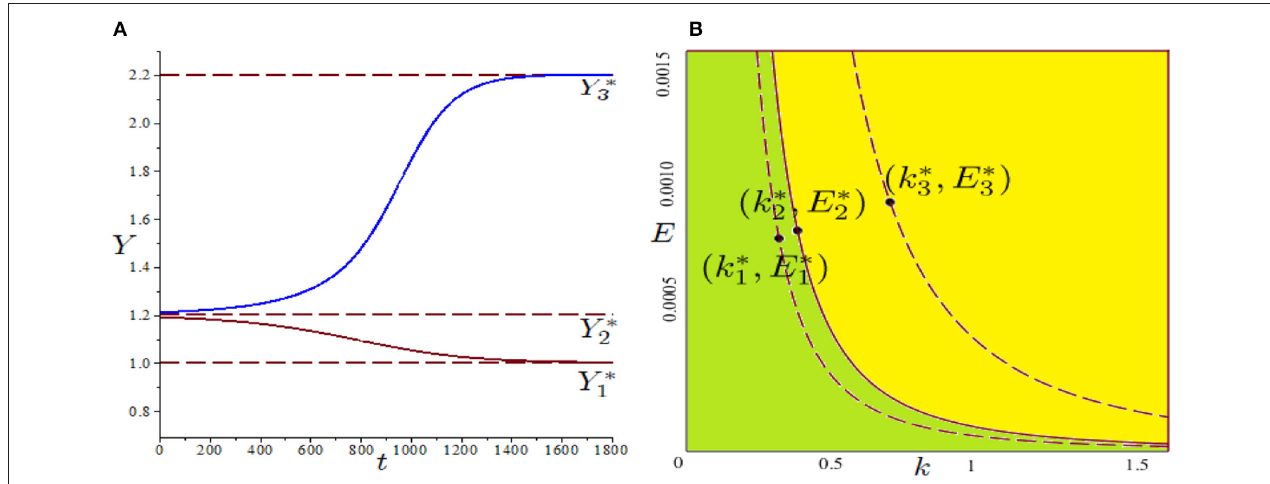
FIGURE 6 | Figure reproduced with the permission of the publisher. Source: Caravaggio and Sodini [14]. Parameter set: α = 0.32, β = 0.6, γ = 0.4, δ = 0.7, θ = 3, λ = 2.87, ρ = 0.25, σ = 0.7, τ = 0.2, φ = 0.6, E = 0.0007, A = 48.6. (A) Time series of Y converging to Y * 1 or to Y * 3 for different initial conditions; (B) Dashed lines describe iso-product curves in the plane ( k , E ) associated with stable fixed points of N , Y * 1 and Y * 3 . The iso-product curve related to the unstable Y * 2 (solid line) is the stable manifold of the saddle ( k * 2 , E * 2 ) and separates the basin of attraction for ( k * 1 , E * 1 ) (green region) and ( k * 3 , E * 3 ) (yellow region), respectively.